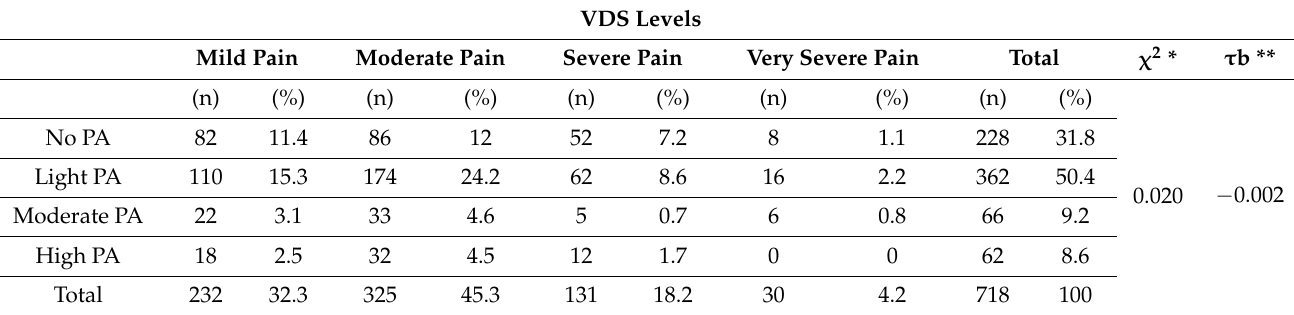
Table 6. Contingency table of physical activity levels and VDS neck